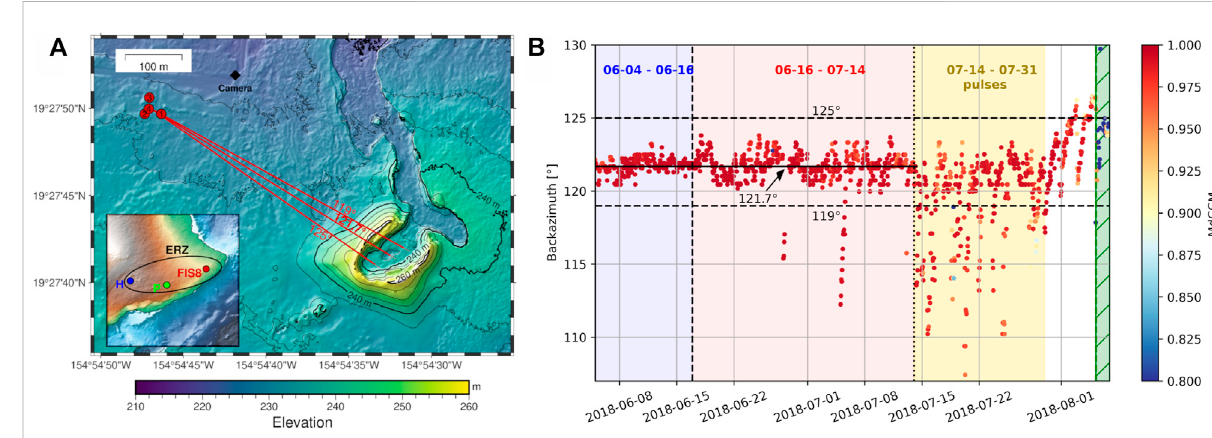
FIGURE 1 Locationoftheinfrasoundarrayandventandarrayprocessingresults. (A) Showsthelocationoftheinfrasoundsensors(redcircles)inrelationto theerupting fi ssure. The red dashed and dotted lines refer to thebackazimuth calculation shown in (B) The black diamond shows thelocation ofthe time-lapse (TL) camera used for estimating the cone growth in Figure 3. The insert map shows the location of mentioned places on the Island of Hawai ‘ i,includingHalema ‘ uma ‘ ucrater(H),EastRiftZone(ERZ),Pu ‘ u ‘ o (cid:1) ‘ o (cid:1) vent(P)andthelocationof fi ssure8andtheinfrasoundarray(FIS8). (B) Shows the backazimuth results for array FIS8. The colors correspond to the median cross correlation maxima (MdCCM) value. The solid black line is the median backazimuth for the time before the majority of the pulses start (before July 14). The dashed lines indicate the approximate extend of backazimuth fl uctuations before the pulses. These threebackazimuths are shown on themap in (A) . The backgroundcolors and vertical dashed and dotted lines in (B) differentiate the time windows labeled in the according colors at the top of the fi